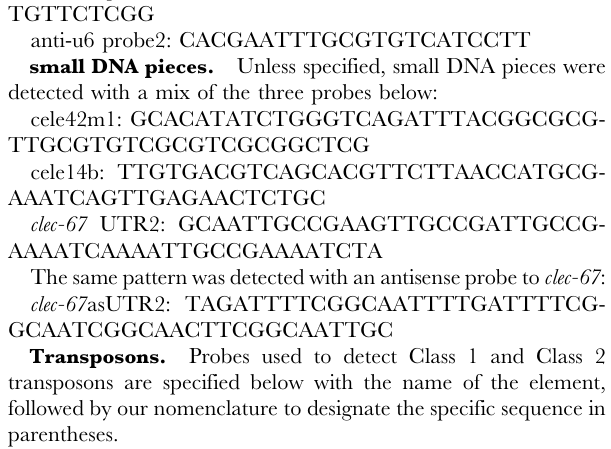
Figure S1 Probes for clec-67 sequences. Nucleotides 1801–2885 of the unspliced clec-67 mRNA (IV:3922159..3925043) are shown with sequences of the seven probes indicated in capital letters.